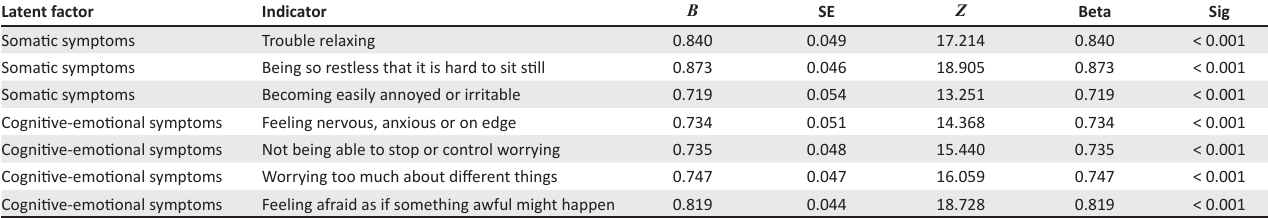
TABLE 3: Unstandardised and standardised factor loadings for the modified two-factor model of the generalised anxiety disorder-7